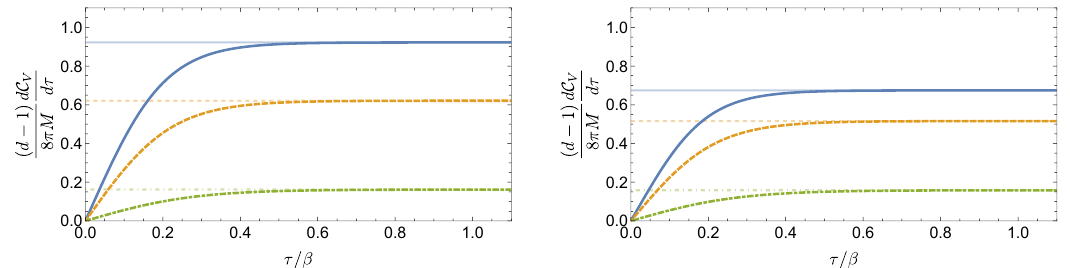
Figure 12 . The time derivative of complexity with d = 4, k = 1 with non-zero chemical potential, by (cid:12)xing the parameters in eq. (4.29). The various curves correspond to: (cid:23) = 0 : 1 in blue (solid), (cid:23) = 1 in orange (dashed) and (cid:23) = 5 in green (dot-dashed) for TR = 1 (left) and TR = 1 Late time limits are obtained from eqs. (3.17), (3.19) and are indicated by horizontal lines of the appropriate